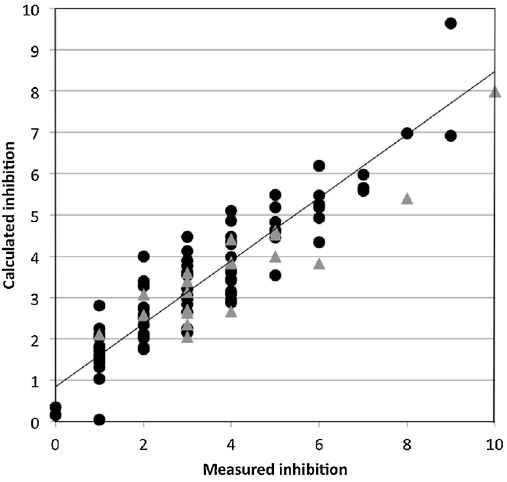
Figure 2. Quantitative prediction of corrosion inhibitory properties of organic compounds for aerospace alloys AA-2024 generated using molecular descriptors (not derived from quantum mechanical calculations). Inhibition is scaled between 0 (no inhibition) and 10 (highest inhibition). The circles represent the performance of the model in predicting training set, and the triangles represent the performance of the model in predicting the test set. Used with permission from Winkler et al. [1].